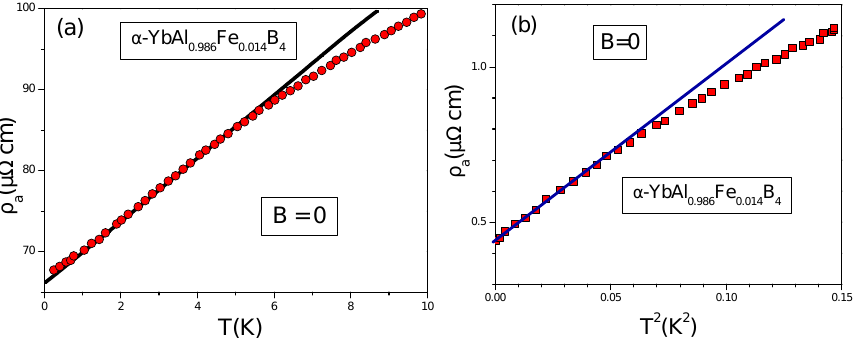
Figure 18. Experimental data for the resistivity ρ a ( T ) : in panel ( a ) resistivity is plotted as a function of T , solid circles and in panel ( b ) resistivity is plotted as a function of T 2 , solid squares. The data are taken from [34]. The solid lines are fits to the experimental